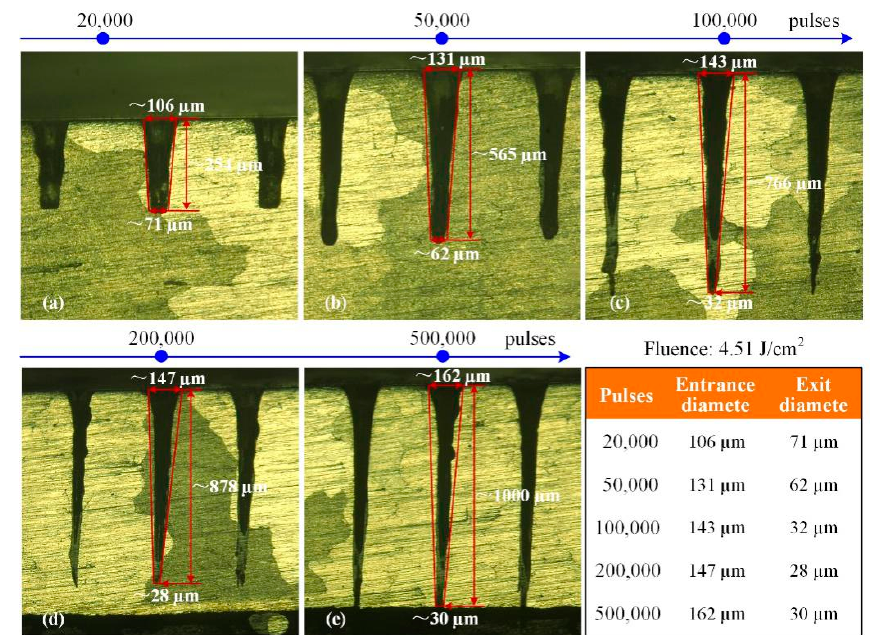
Figure 10. Metallographic images of holes side-walls in Ni-based superalloy. ( a ): 20,000 pulses ( b ): 50,000 pulses ( c ): 100,000 pulses ( d ): 200,000 pulses ( e ): 500,000 pulses.